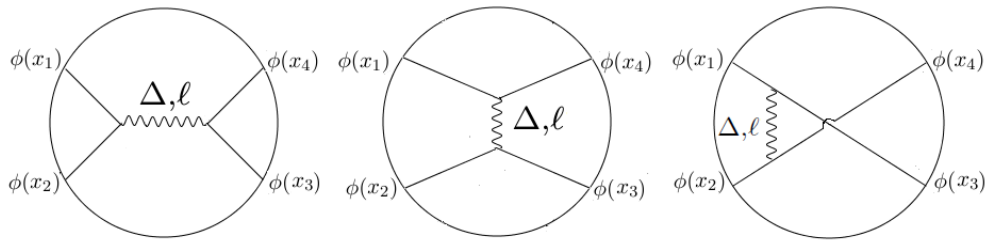
Figure 1 . Witten Diagrams in AdS d +1 for identical scalars with exchange of a (cid:12)eld corresponding to an operator of dimension (cid:1) and spin ‘